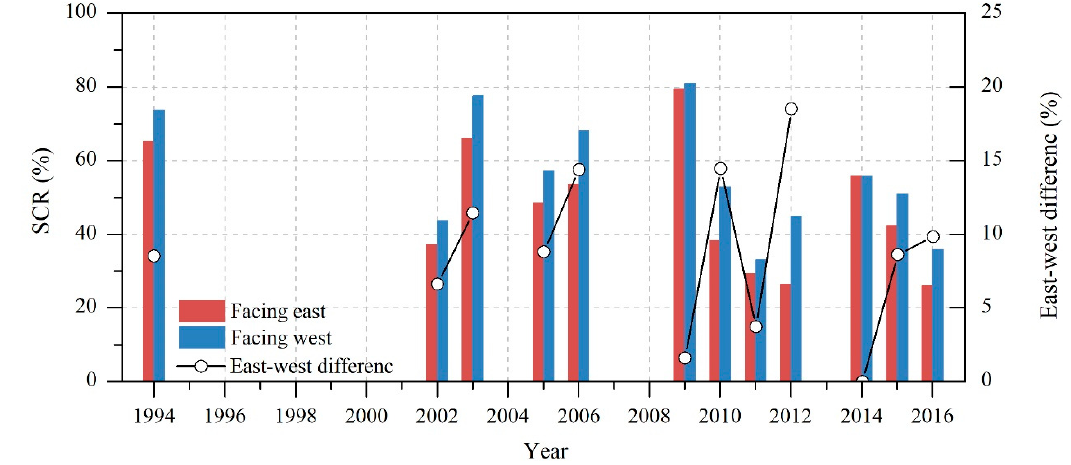
Figure 7. The annual snow-cover ratio (SCR) on the eastern slope and western slope and their differences over 1994 ‒ 2016.